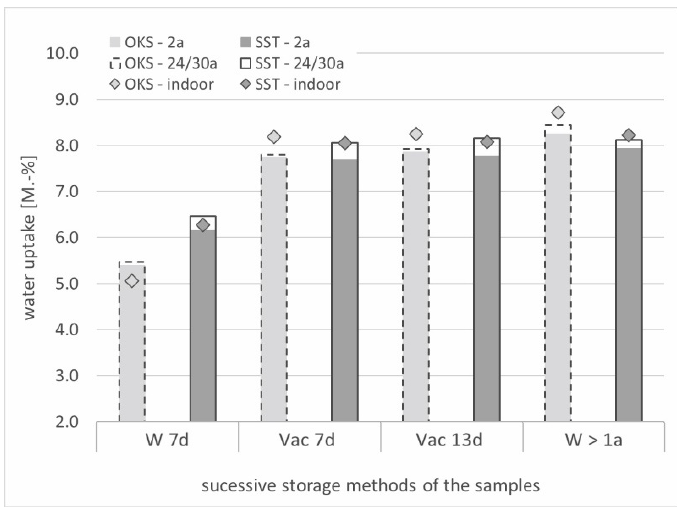
Figure 4. Water ingress of Obernkirchener and Schleeriether Sandstone samples over successive storage methods. Mean values of the different outdoor exposures (see Table 2).